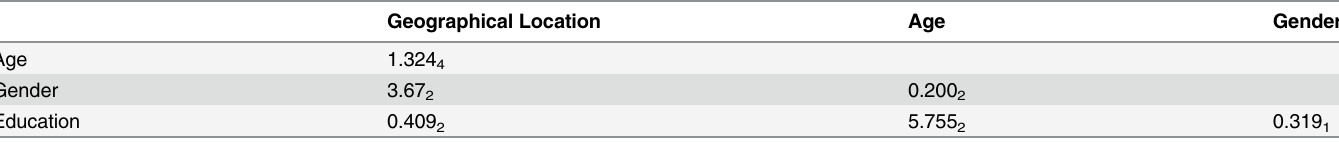
Table 2. Pearson Chi-Square of Demographic Variable